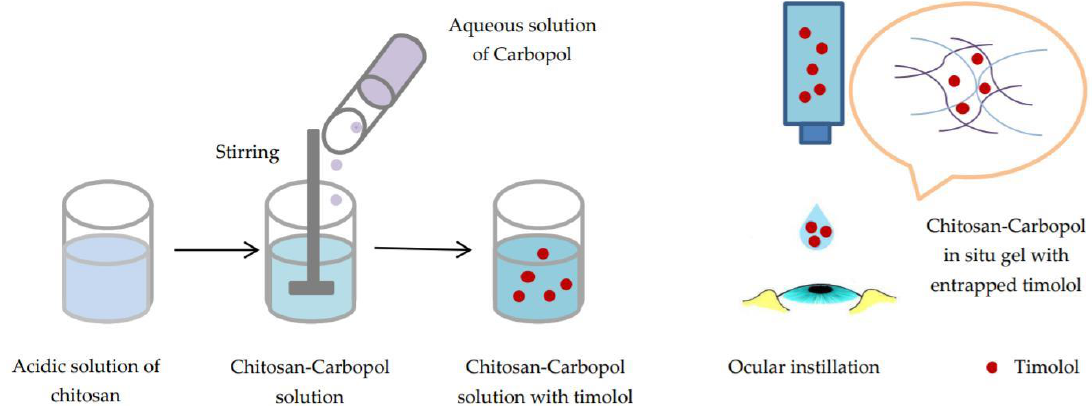
Figure 8. Chitosan-Carbopol in situ gel for ocular delivery of timolol.